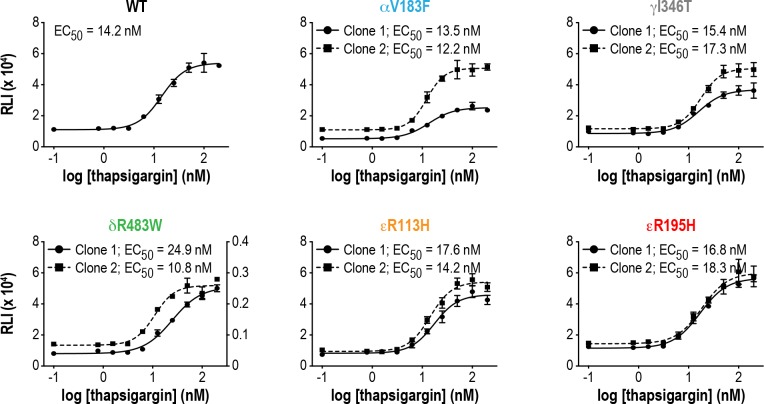
VWMD mutant cells show a similar response to ER stress as WT cells.Tg dose-response curves of ATF4-luciferase reporter activity in WT and VWMD cell lines. Cells were treated with increasing concentrations of Tg for 7 hr (N = 3, mean ± SD). The values for δR483W clone #1 are plotted on the right y-axis, due to the low luminescence output from this clone.